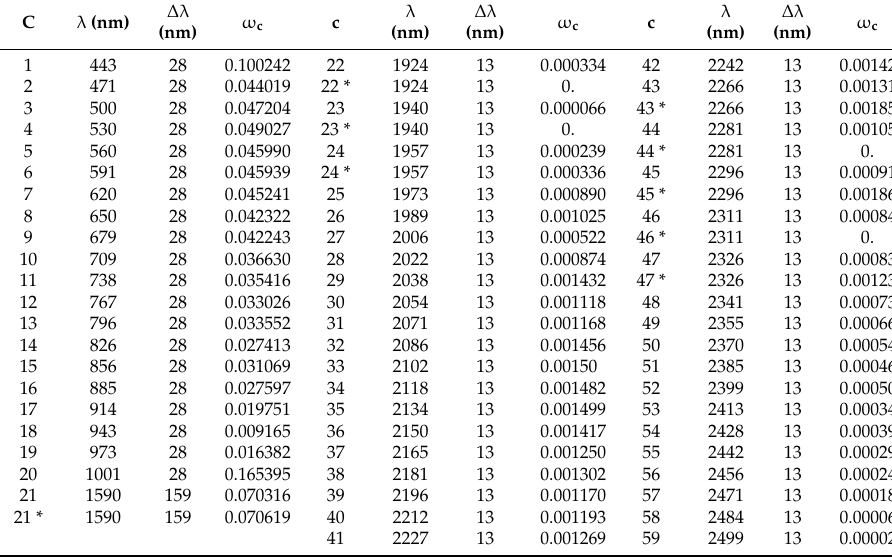
Table 4. Weighting coefficients ( ω c ) of AHS channels 1 to 59 for the calculation of the Integrated Albedo. For each channel, the identification number (c), the central wavelength ( λ ), and the bandwidth ( ∆ λ ) are also given. ∆ λ corresponds to the Full Width at Half Maximum (FWHM). Values with asterisks are calculated without the contribution of channels 22, 23, 44, and 46 due to their low